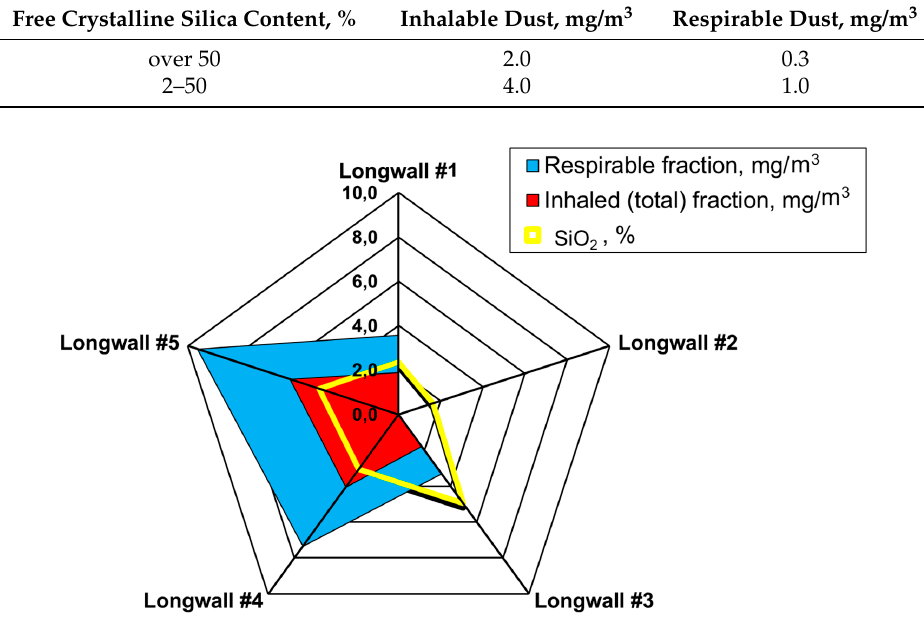
Figure 10. The average exceedance rate of the MAC values for dust in the longwalls under